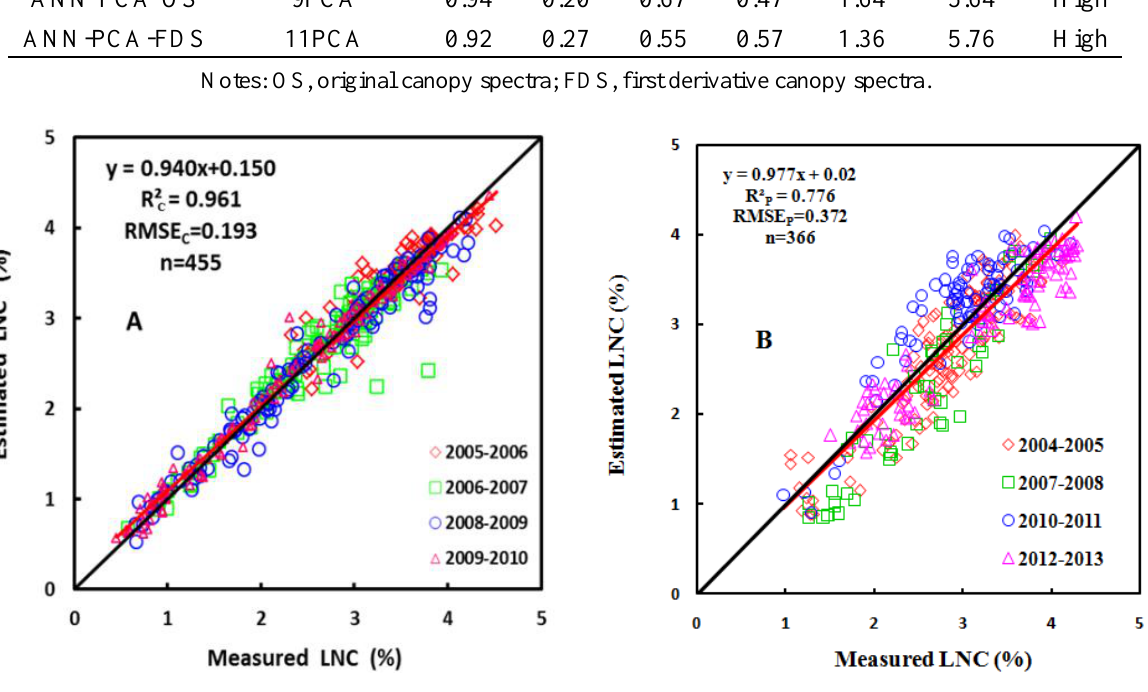
Figure 9. The 1:1 relationship between the measured LNC and those estimated using the SVM-FDS model for the calibration ( A ) and validation ( B )